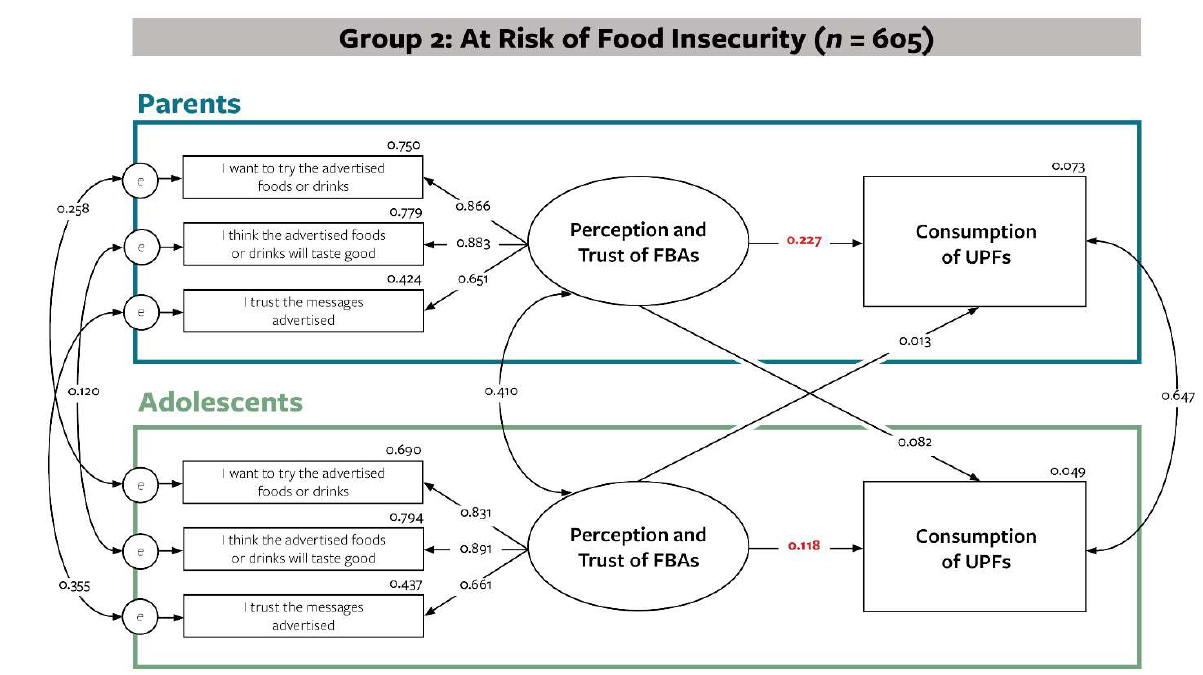
Figure 4. Actor and partner effects of perception and trust of FBAs and consumption of UPFs in parent-adolescent dyads accounting for food insecurity. Significant regression coefficients are bolded in red. Both models adjusted for parents’ sex and parents’ education level. ( a ) SEM model results for dyads not at risk of food insecurity; ( b ) SEM model results for dyads at risk of food insecurity. Model fit: ∆ χ 2 = 59.794 & 45.814, df = 26, p = 0.001; RMSEA = 0.037 (90% CI = 0.027 to 0.047), p = 0.98; CFI = 0.990; SRMR = 0.036; AIC = 44485.329.